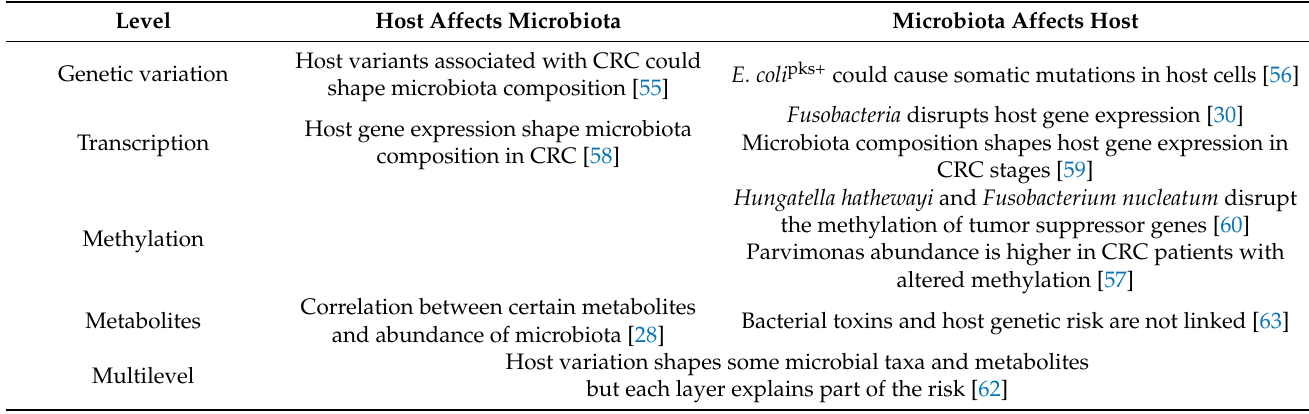
Table 2. Summary of the findings about host–microbiota interactions in colorectal